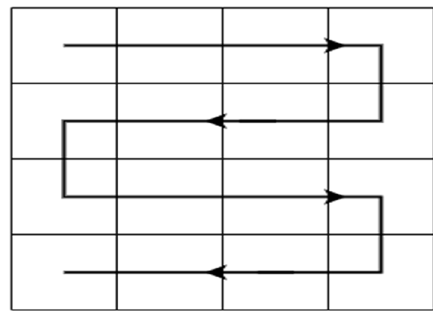
Fig. 8 Scan pattern with 16-bit input and 16-bit output